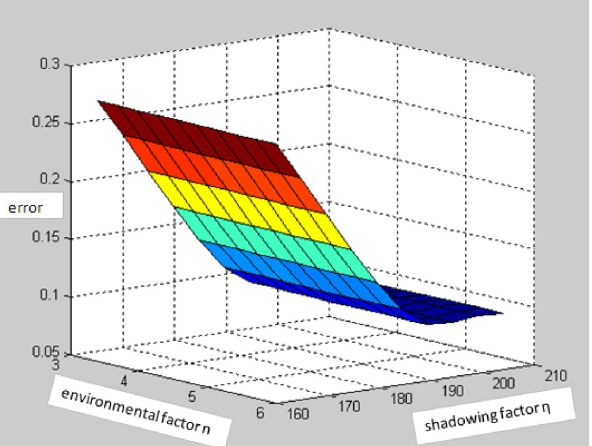
Figure 10. Three-dimensional coordinate graph basing on Figure 1